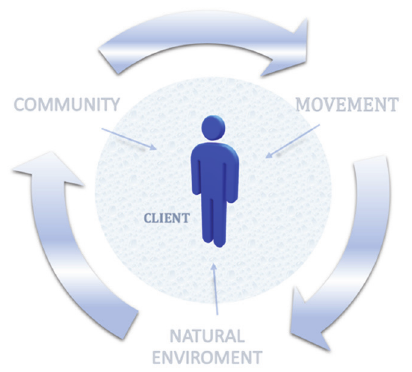
Figure 3. Mediators of the surf therapy process.